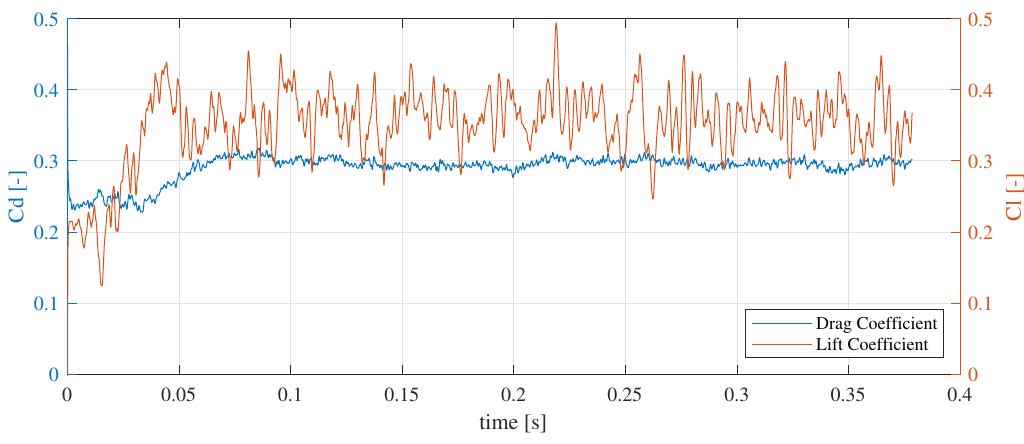
Figure 12. Drag and lift coefficients as a function of time for the LES turbulence model.